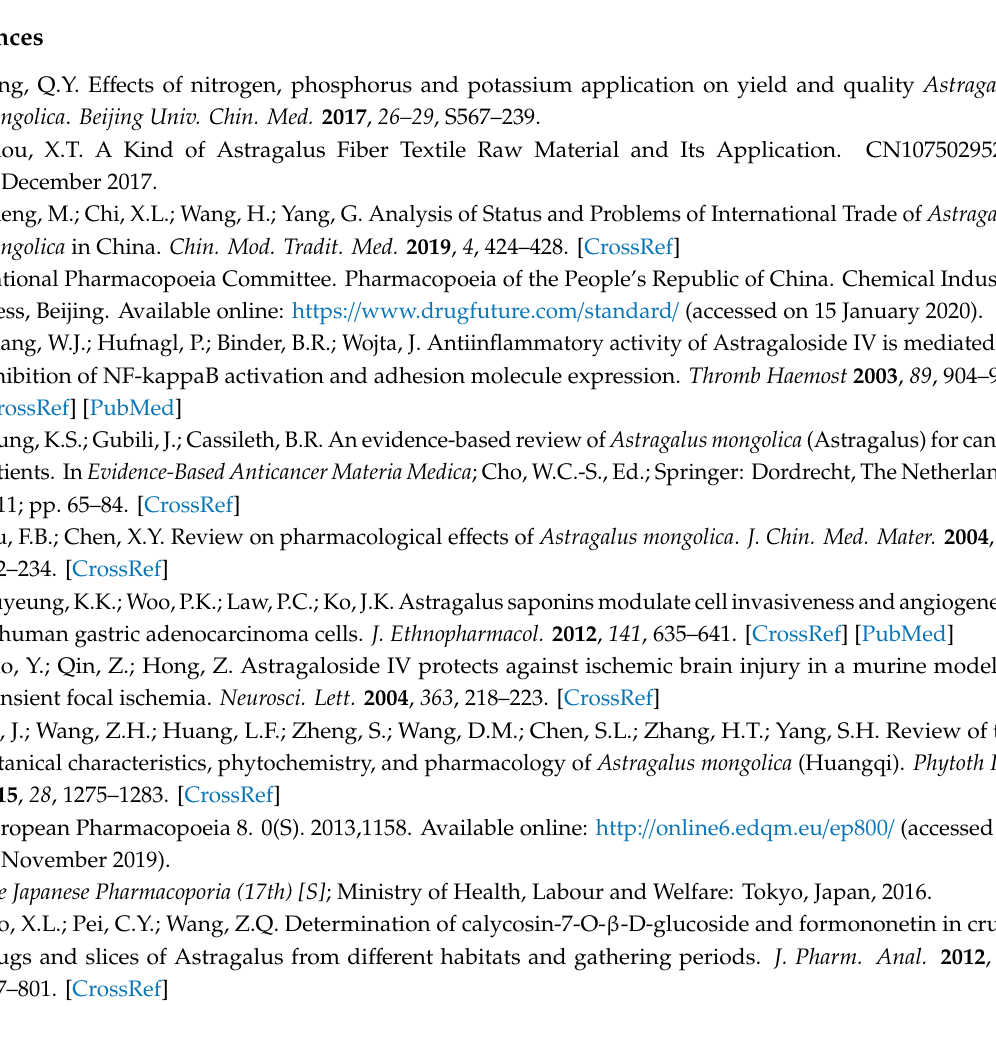
Supplementary Materials: The following are available online. Table S1: The data of yield and active components of Astragalus mongolica under di ff erent nitrogen fertilizer levels: 37.5 kg / ha (N1), 75 kg / ha (N2), 112.5 kg / ha (N3), 150 kg / ha (N4), and 187.5 kg / ha (N5). Table S2: Standardization of the data of Astragalus mongolica yield and active components under di ff erent nitrogen fertilizer levels: 37.5 kg / ha (N1), 75 kg / ha (N2), 112.5 kg / ha (N3), 150 kg / ha (N4), and 187.5 kg / ha (N5). Table S3: Relation coe ffi cients and degrees of evaluation units relative to the best evaluation sequence for yield and active components data of Astragalus mongolica under di ff erent nitrogen fertilizer levels: 37.5 kg / ha (N1), 75 kg / ha (N2), 112.5 kg / ha (N3), 150 kg / ha (N4), and 187.5 kg / ha (N5). Table S4: Relation coe ffi cients and degrees of evaluation units relative to the worst evaluation sequence of yield and active components data of Astragalus mongolica under di ff erent nitrogen fertilizer levels: 37.5 kg / ha (N1), 75 kg / ha (N2), 112.5 kg / ha (N3), 150 kg / ha (N4), and 187.5 kg / ha